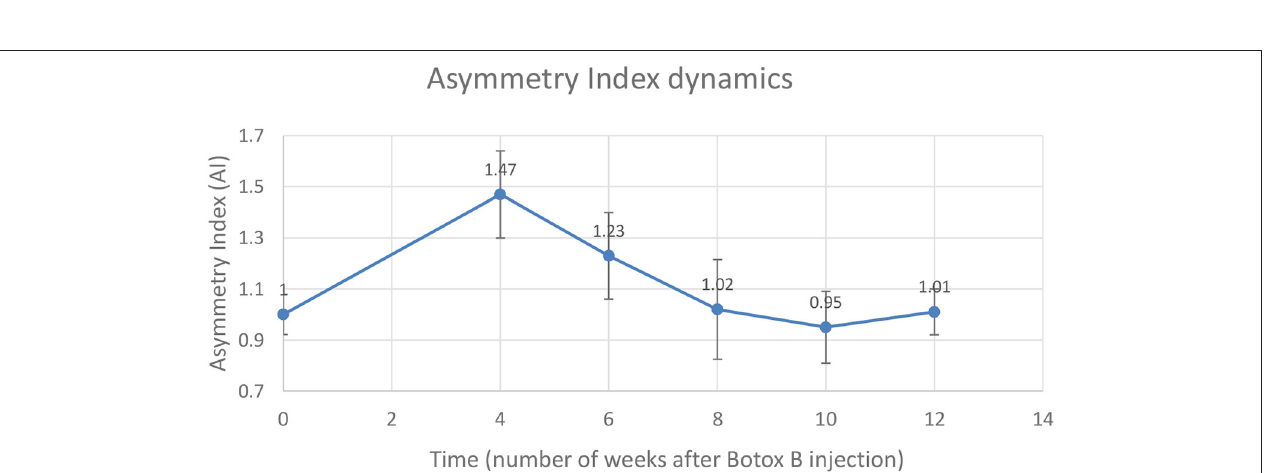
screen of the GE Ultrasound machine ( Figures 2C–E ). Schematics of the injection spots in the study, 9-23-20 ( Figure 2F